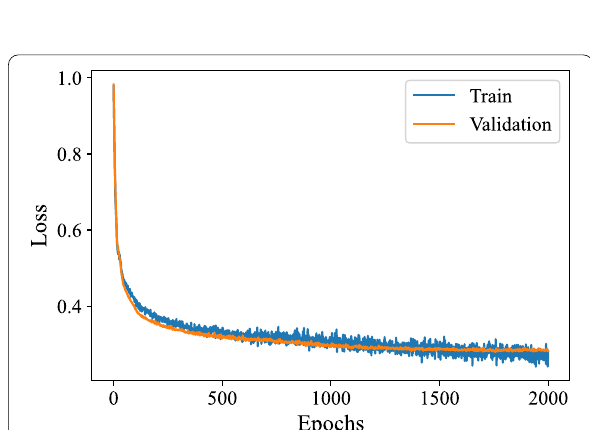
Fig. 3 Model workflow.